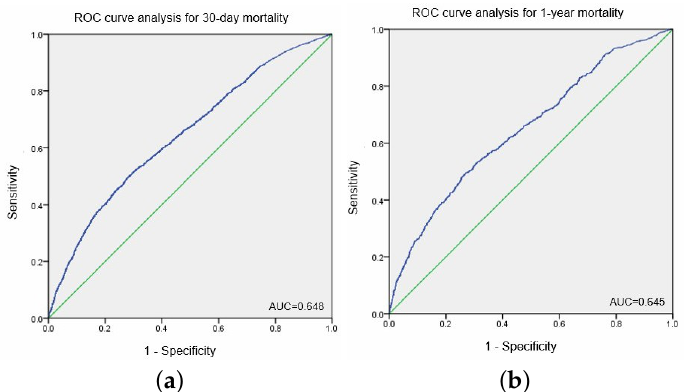
Figure 2. Receiver operative curve analysis for 30-day mortality ( a ) and 1-year mortality ( b )